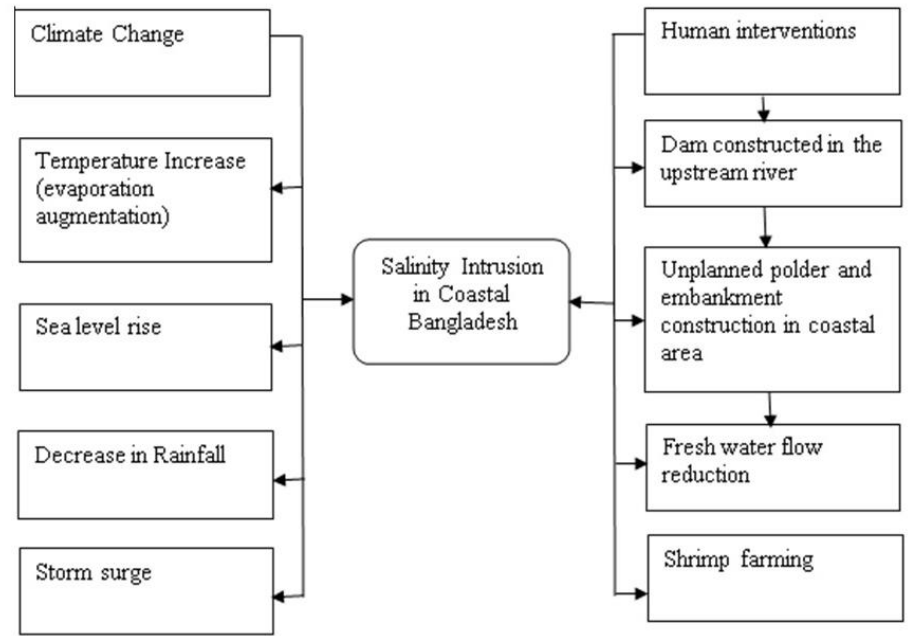
Figure 1. Pathway of salinity intrusion (Source: Modified from